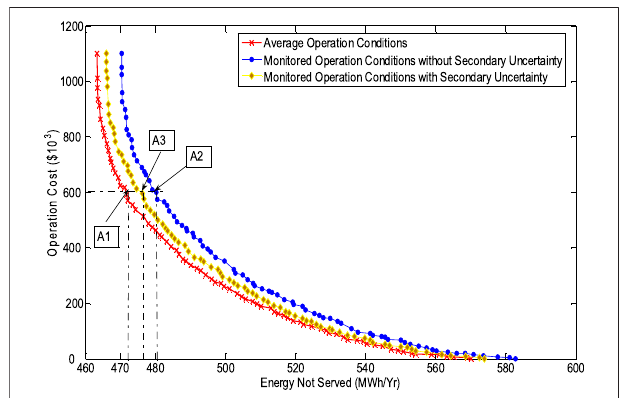
FIGURE 14 | Failure probability variation of circuit breakers with each individual operation condition.